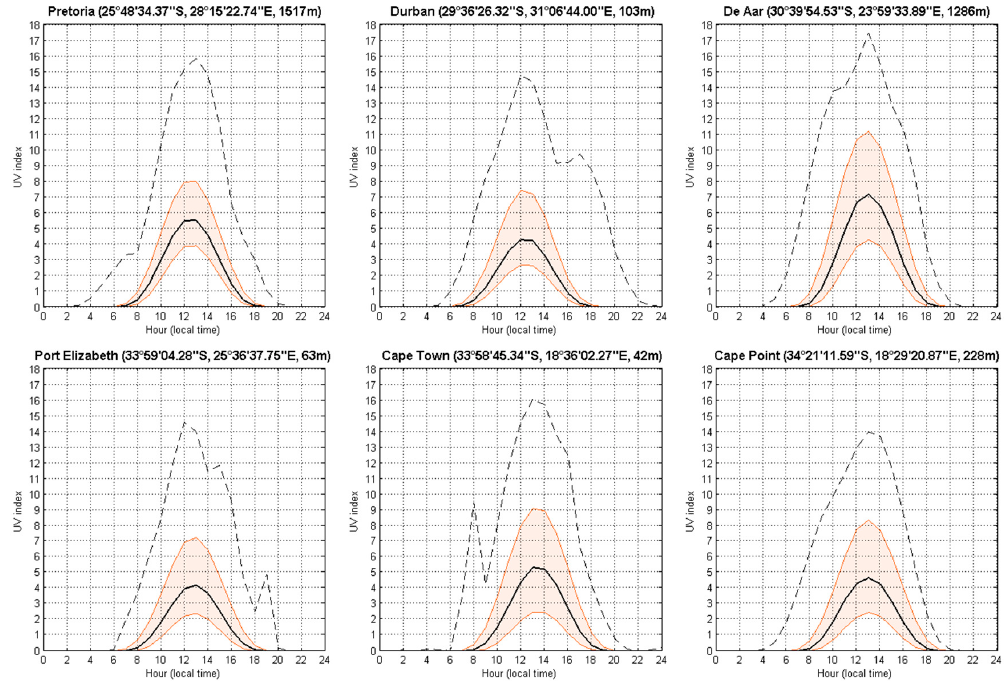
Figure 3. Daily climatological median (black line) of the solar UVI for the six South African sites, for all years of observation (i.e., 1994–2015). Quantile 25 and 75 (filled orange lines) and minimum and maximum (black dash line) are also